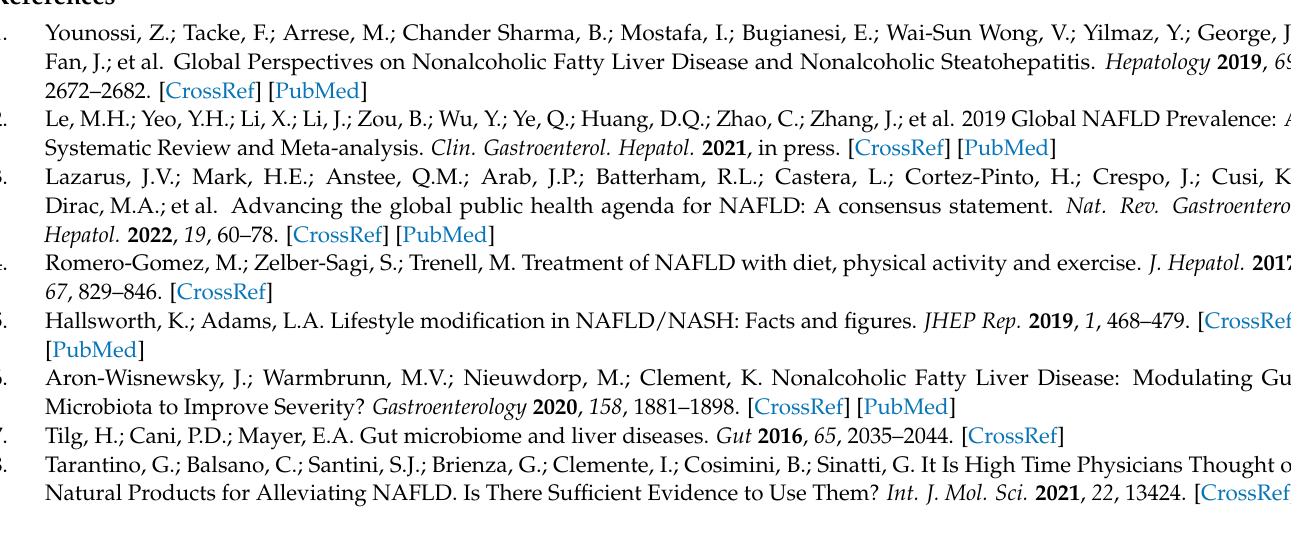
summary; Table S3: Post- and pre-treatment changes ( ∆ ) of relative abundance at the family level in the oligonol and placebo groups; Table S4: Patients with percent MRI-PDFF decreased ≥ 10% at week